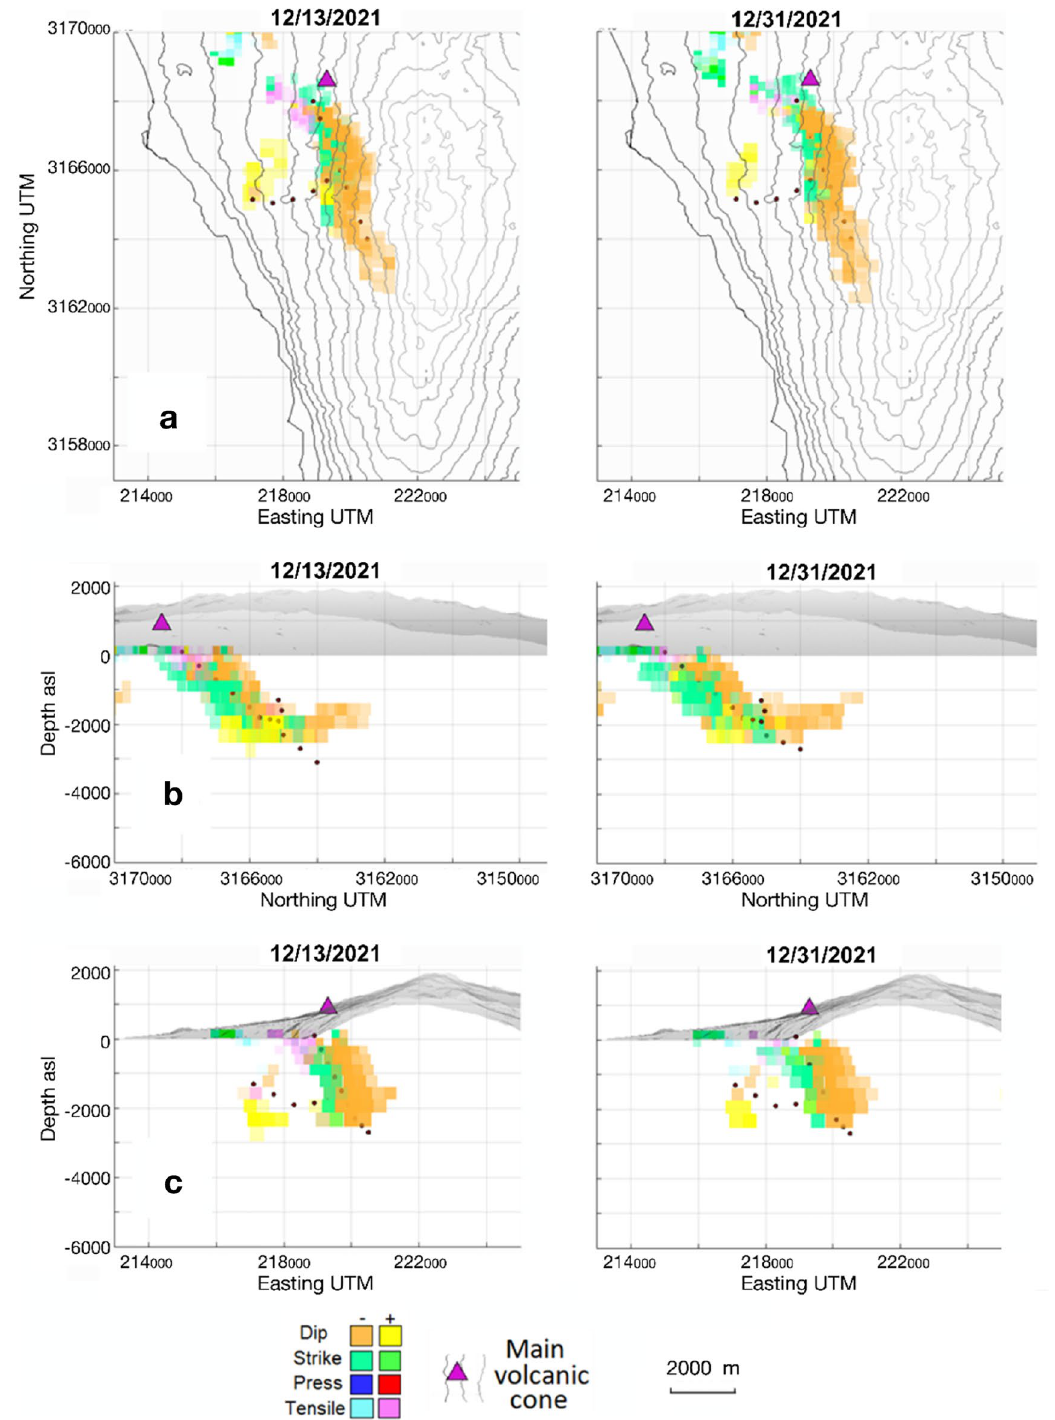
Figure 8. Time evolution of the modeled sources around the end of the eruption. ( a ) Horizontal, ( b ) vertical N-S and ( c ) vertical W-E projections of the sources obtained for different epochs in 2021.95 (12/13/2021, end of the eruption) and 2021.99 (12/28/2021, one of the initial post-eruptive steps). The different plots show the time evolution of the different sources obtained from inversion of Sentinel-1 ascending and descending LOS displacement. Purple triangle shows the location of the main volcanic vent during the 2021 La Palma eruption. Red dots indicate the inferred direction of magma flows from deeper areas. Matlab (www. mathw orks. com) and GMT (www. gener ic- mapin- tools. org) softwares were used to create this figure. This figure complements with Supplementary Movies